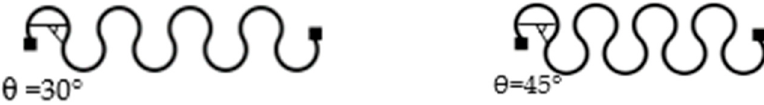
Figure 3. Horseshoe patterns at various angles using AutoCAD software.